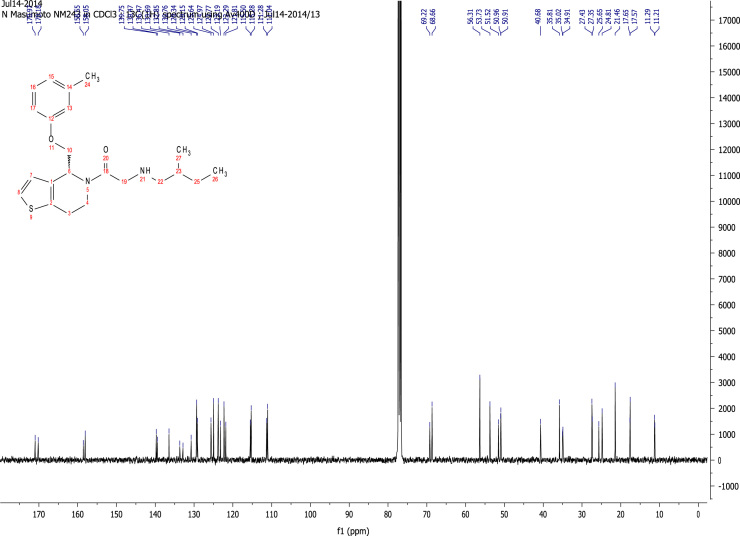
13C NMR (101 MHz, CDCl3) of RU-SKI 43
(9b).